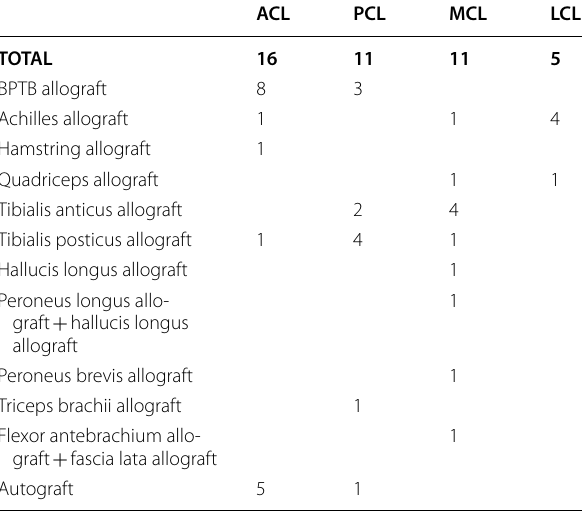
Table 3 The various grafts used for the different ligament injuries